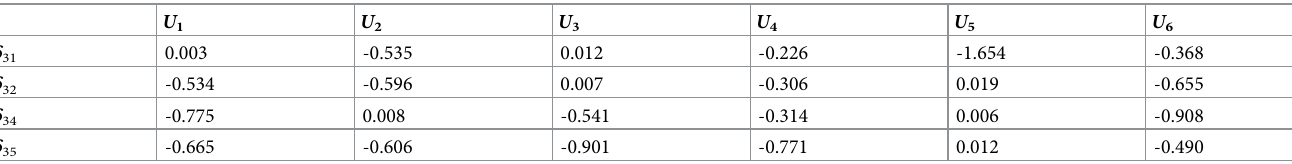
Table 21. The relative dominance of O 3 to others.